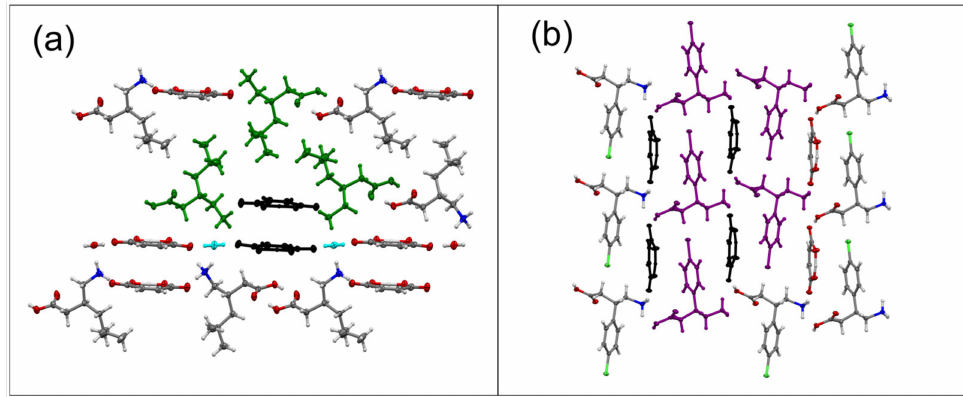
Figure 3. Packing in ( a ) ( S )-3-MA • H 2 O view along the c-axis and ( b ) 5-MA view along the c-axis. Motifs are highlighted according to the chosen color scheme; oxygen atoms are depicted in red, nitrogen atoms in white, carbon atoms in grey and hydrogen atoms in white.